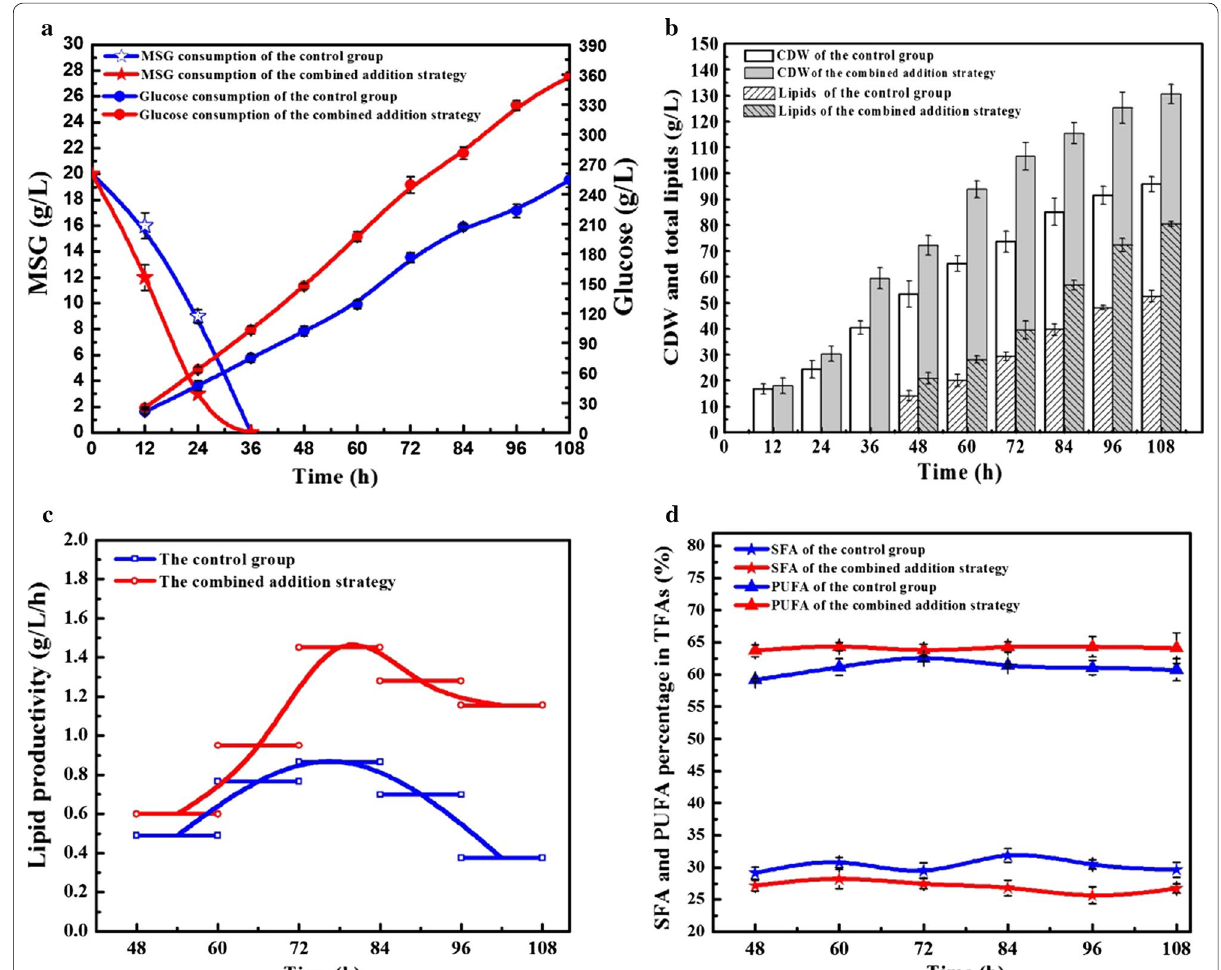
Fig. 1 Comparison between the control group and the combined addition strategy in a 5‑L bioreactor: a substrate consumption, b CDW and lipid